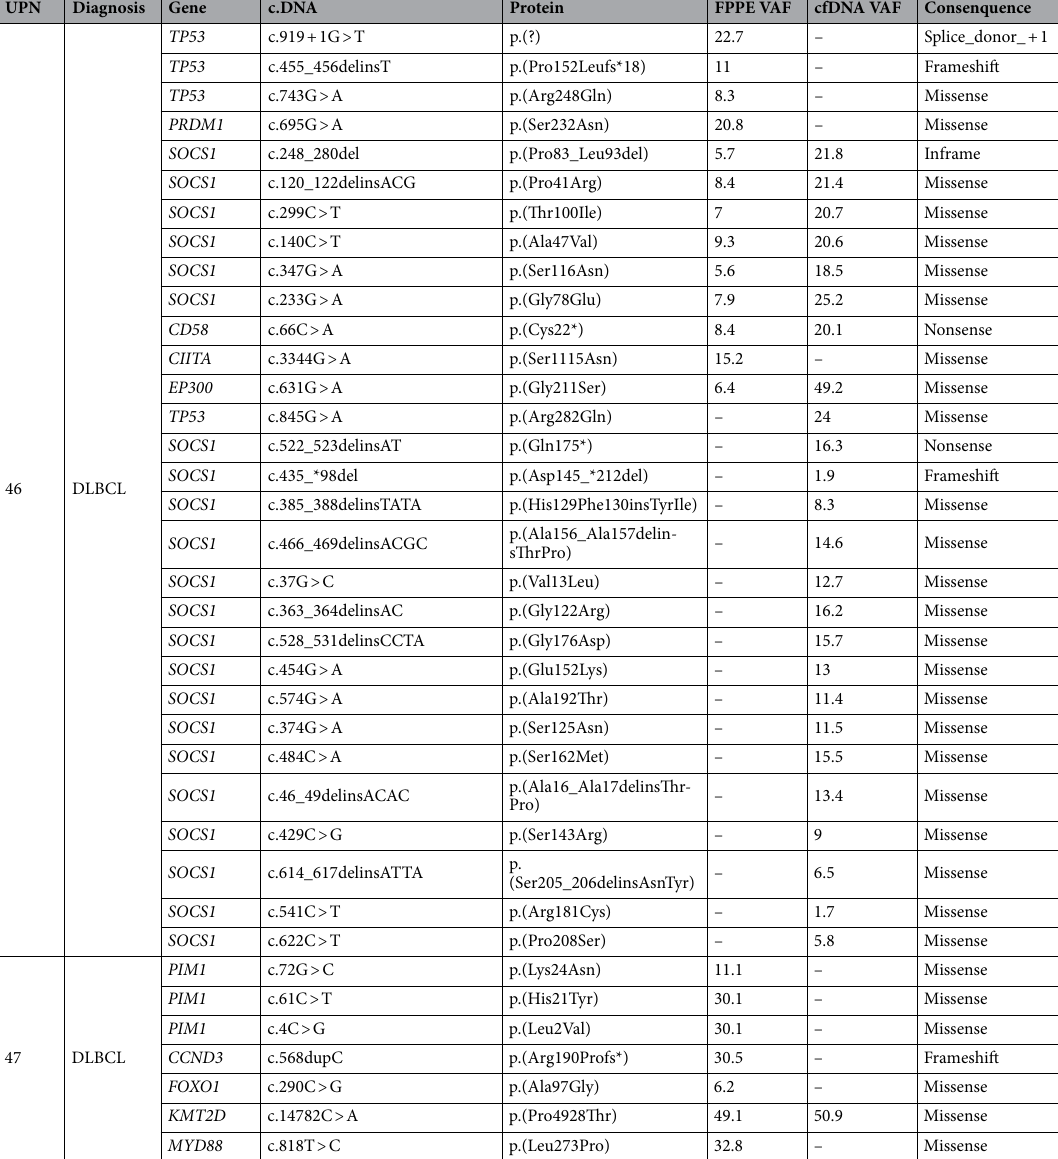
Table 2. Mutational analysis of circulating tumor DNA and formalin-fixed paraffin-embedded tissue